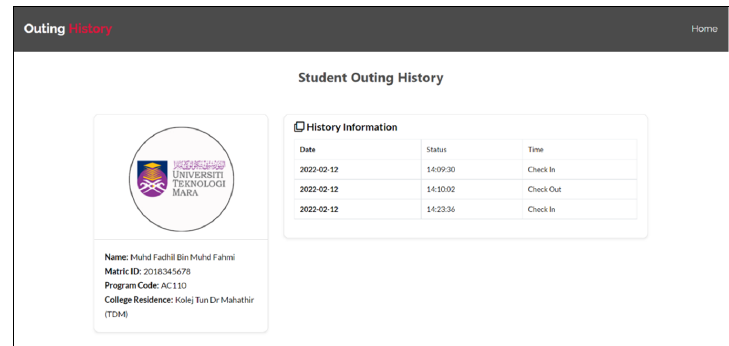
Figure 6. Students’ outing history page.